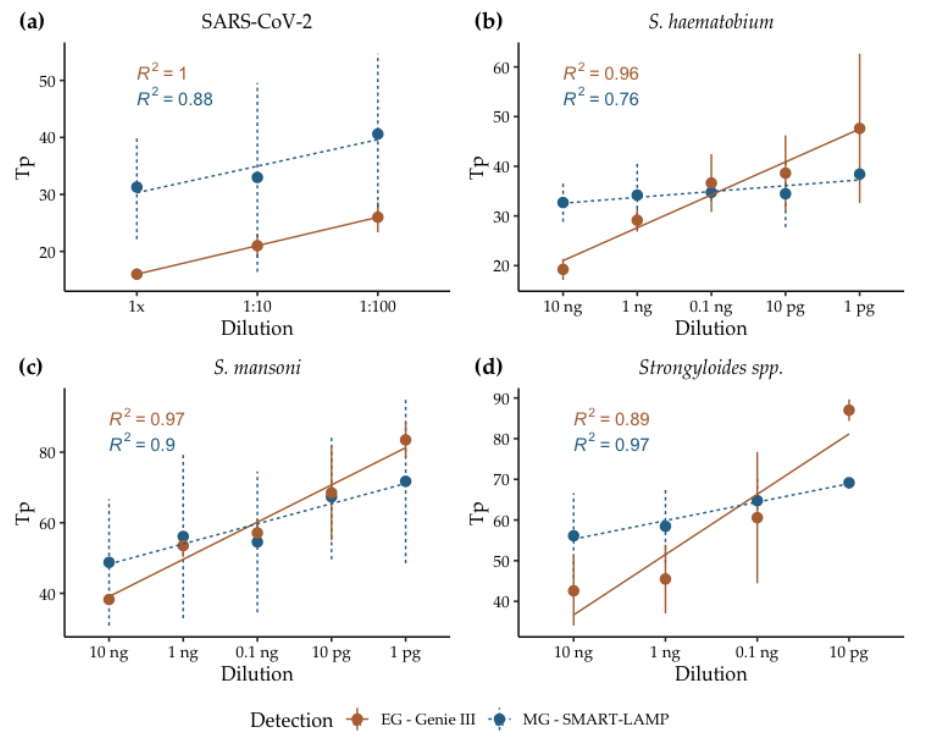
Figure 5. Sensitivity of real-time dry-LAMP assays performed in the Genie III (EG) and the SMART- LAMP (MG) devices: ( a ) SARS-CoV-2; ( b ) S. haematobium ; ( c ) S. mansoni ; ( d ) Strongyloides spp .